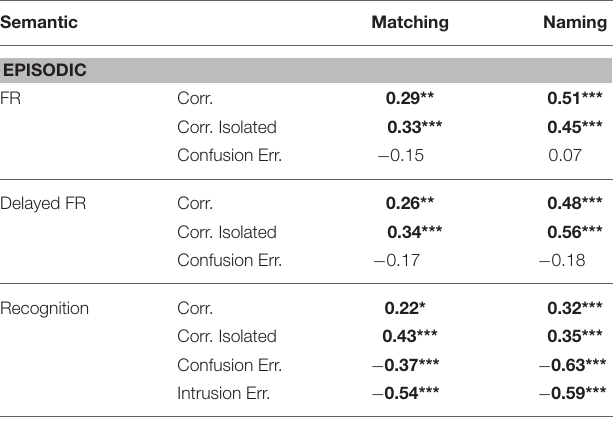
TABLE 6 | Correlation analysis between the semantic (matching and naming) scores and the episodic (free recall, recognition, errors) scores of the SEMEP across all groups of participants (young adults, healthy elderly and patients with Alzheimer’s